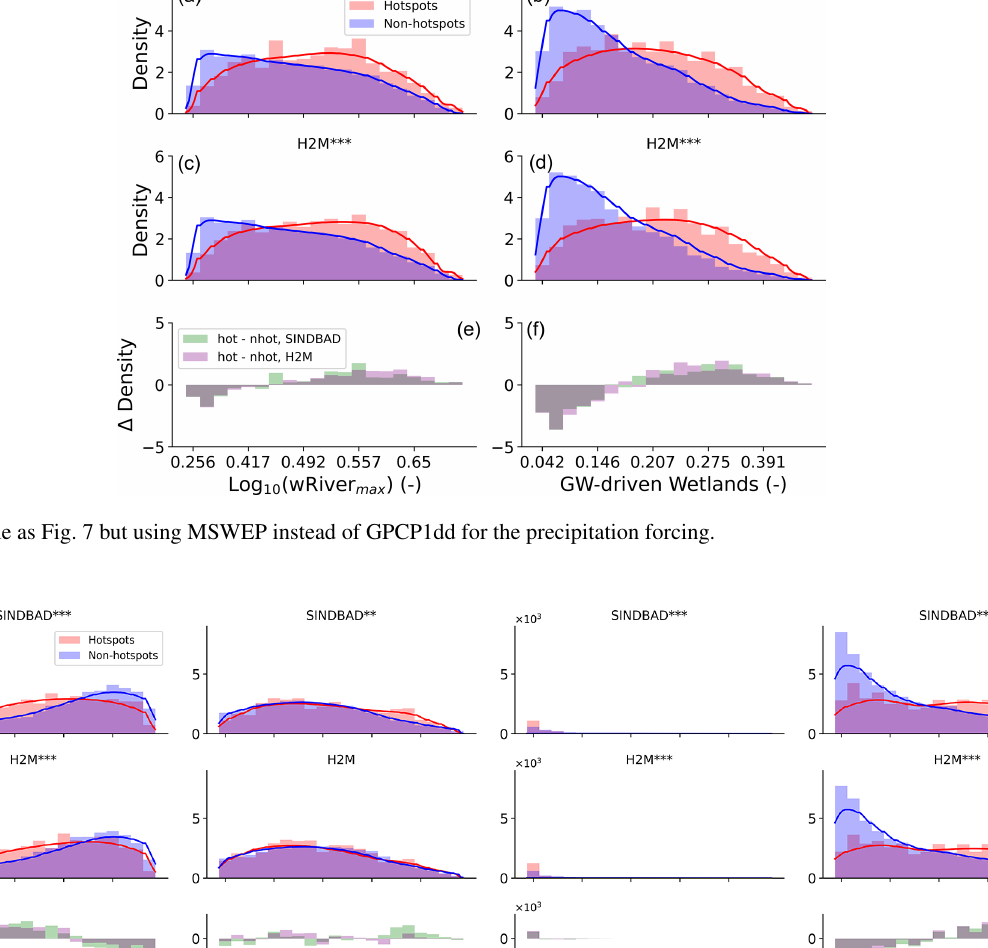
Code and data availability. The SINDBAD and